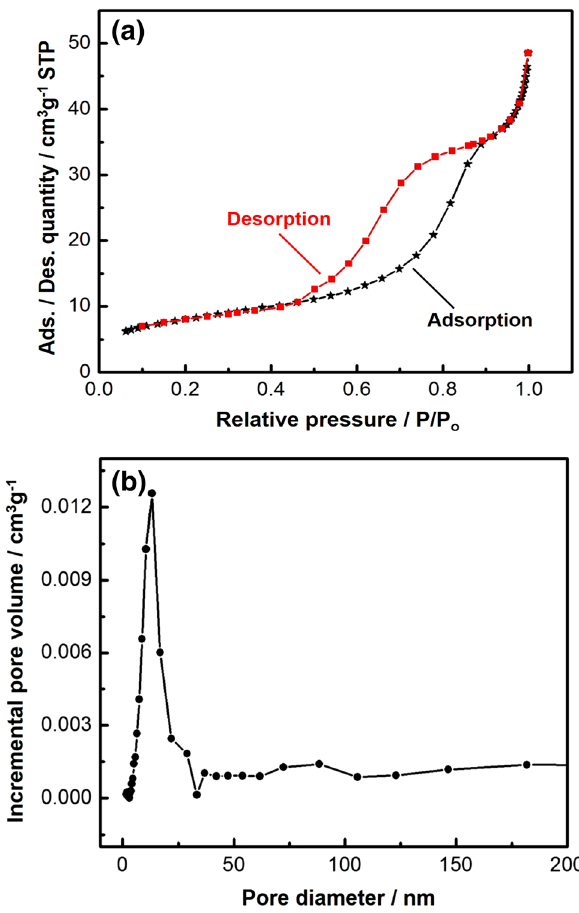
Figure 4. ( a ) N 2 Adsorption–desorption isotherm of the prepared Co x Ni 1−x Fe 2 O 4 ; x = 0.9/SiO 2 /TiO 2 /C-dots nanocomposite; ( b ) Pore size